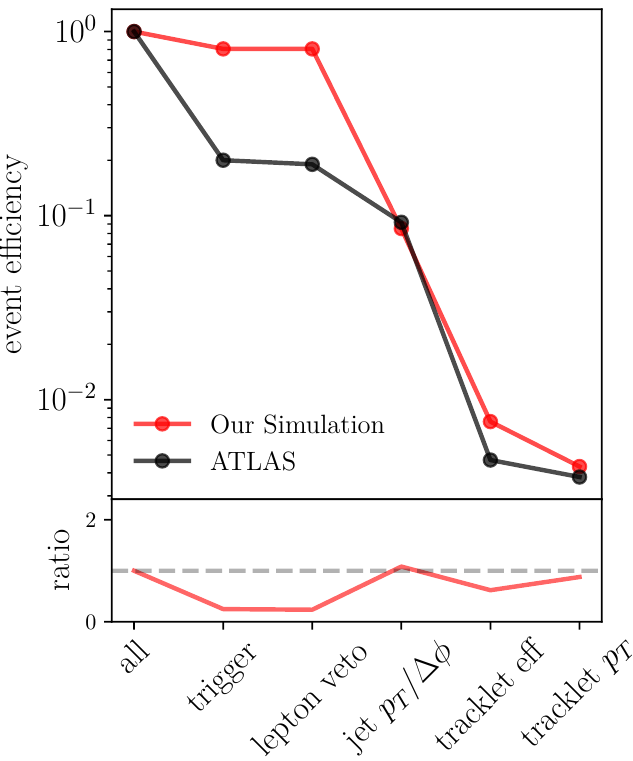
Figure 4 . Validation of the ATLAS disappearing track search efficiency for a chargino produced , cτ electroweakly with ( m ) = (400 GeV , 59 . 96 mm) . The black curve corresponds to the ATLAS ˜ χ ± 1 ˜ χ ± 1 efficiency in table 1 of ref. [35] and the red curve corresponds to our simulation. The bottom rectangle shows the ratio of ATLAS’s result to our